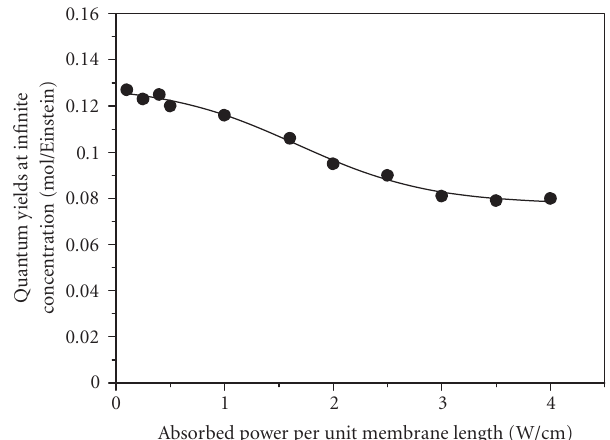
Figure 8: Quantum e ffi ciencies Φ ∞ (mol/Einstein) of methane, ex- trapolated by (17), at infinite concentration of substrate, relative to measurements carried out in the gaseous phase, and corresponding to an absorbed power per unit length of irradiated photocatalytic membrane, expressed of 4.0W · cm − 1 , as a function of mol/mol % of vanadium, used as photopromoter in the photocatalytic mem- branes, with respect to titanium present as main